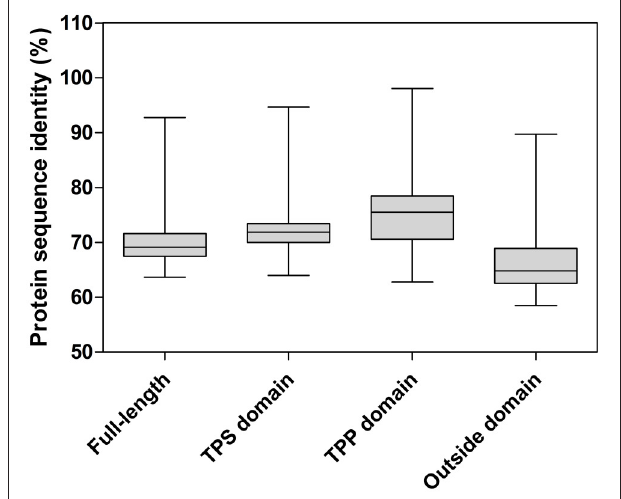
FIGURE 2 | Pairwise sequence identity of full-length TPS proteins. Pairwise sequence identities between TPS domain, TPP domain, full length protein sequence, and sequence outside domain were calculated. The boxplot shows the median (black line), interquartile range (box), and maximum and minimum scores (whiskers) for each data set.